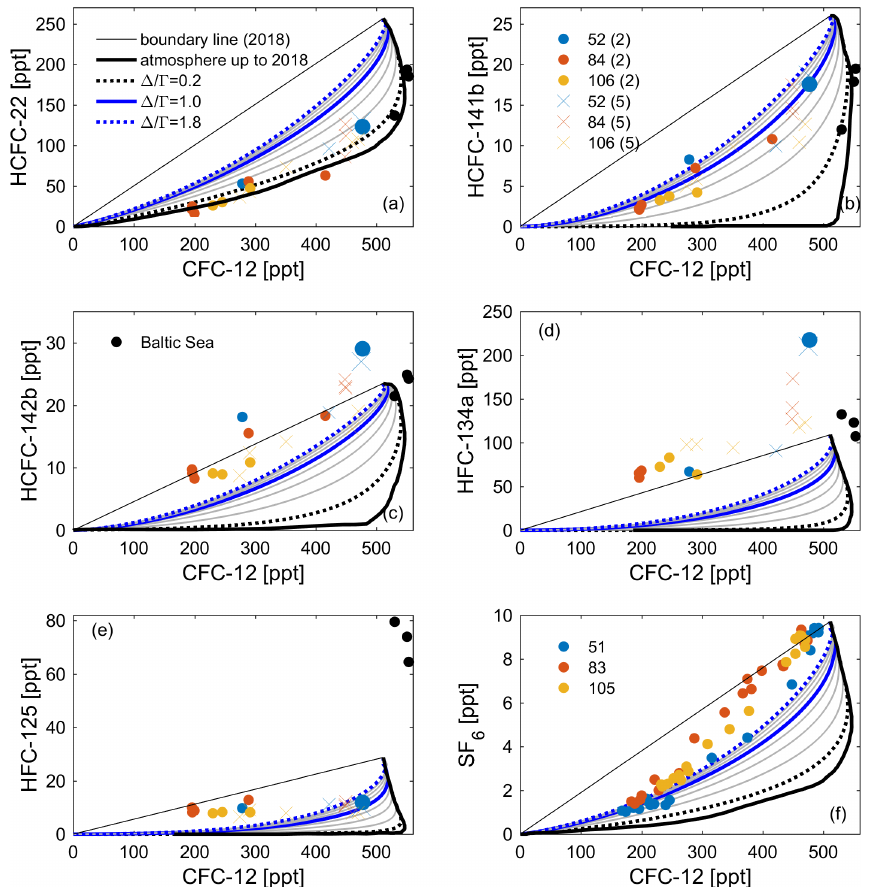
Figure 10. Observations of (a) HCFC-22, (b) HCFC-141b, (c) HCFC-142b, (d) HFC-134a, and (e) HFC-125 in profiles 52, 84, and 106 measured by the Medusa–Aqua system and (f) SF 6 in profiles 51, 83, and 105 measured by PT-GC-ECD plotted against (interpolated) CFC- 12 based on measurements by PT-GC-ECD in the Mediterranean Sea. Observations of tracers from cruise AL516 in the Baltic Sea have been added (black dots). The thick black line is the atmospheric history of the tracer pair ( (cid:49)/(cid:48) = 0.0), and the thin black line is the theoretical mixing line between contemporary and pre-industrial concentrations. The theoretical mixing lines assuming an IG-TTD with (cid:49)/(cid:48) = 0.2–1.8 have also been added. The values of the top two points of profile 52 are bigger to identify the samples in shallow layers. For an explanation of the values (2 and 5) and symbols (dots and crosses), refer to Fig.